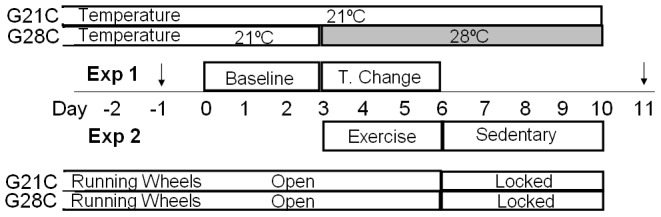
Study schematic.Initial temperature for both groups of mice (n = 8 mice/group) was 21°C. Starting on day -10 all mice were acclimatized to wheel running with the wheel locked for 3 days followed by 7 days of spontaneous running. Subsequently, continuous measurement of outcome variables was performed in metabolic cages for 10days (day 0–10). Experiment 1: Baseline measurement period (day 0–2) was equal in both groups of mice (n = 8) in that both groups were studied at 21°C. Ambient temperature was raised to 28°C for mice in the G28C group starting on day 3 and continued to the end of the study. Day 3–5 was evaluated as the temperature change (T. Change) period for Experiment 1. For Experiment 2 both groups had free running wheel access for spontaneous exercise. For both G21C and G28C day 3–5 was the exercise (EX) period evaluated. Running wheels were locked on day 6 and day 6–10 was evaluated as the sedentary (Sed) period for both groups. Throughout Experiment 2 ambient temperature was 21°C for G21C mice and 28°C for G28C mice. Arrows indicate the two days that body composition measurements were performed.